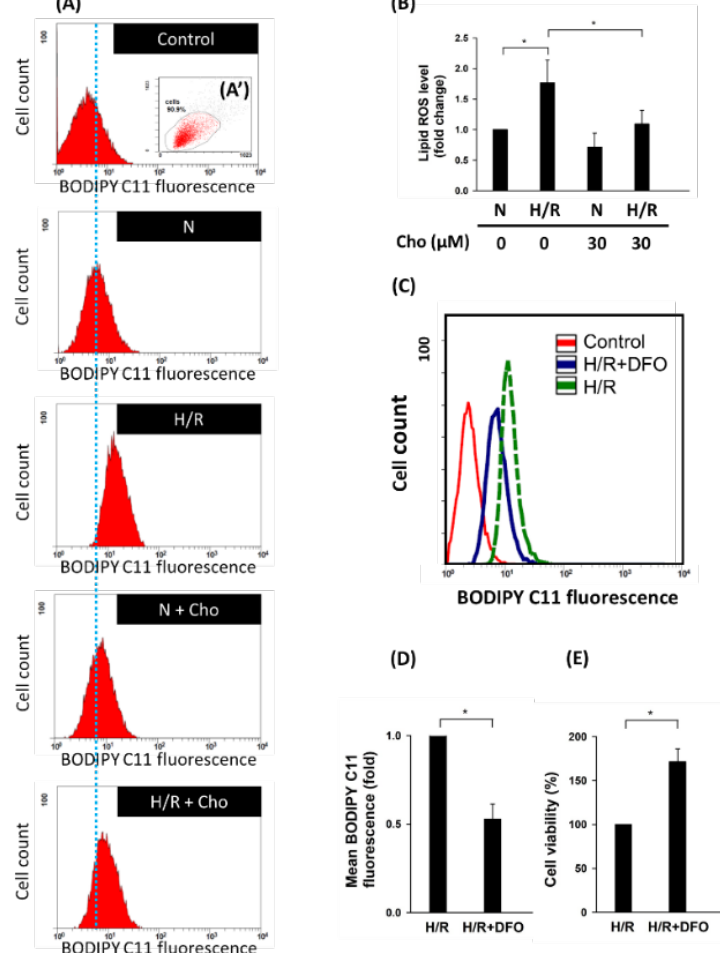
Figure 3. Chrysophanol reversed H/R-induced lipid ROS production. ( A ) Changes in cellular lipid ROS levels of control (without C11-BODIPY staining), N (cells grown in normal oxygen conditions without chrysophanol treatment), H/R (cells cultured in hypoxia/reoxygenation conditions, as described in Section 2), N + Cho (cells grown in normal oxygen conditions with 30 µ M chrysophanol treatment), and H/R + Cho (cells cultured under hypoxia/reoxygenation conditions with 30 µ M chrysophanol treatment) groups. (A) Cells were selected based on morphology. ( B ) ROS generation is expressed as mean fluorescence intensity. ( C ) Changes in cellular lipid ROS levels of control (without C11-BODIPY staining). H/R + DFO (cells cultured under hypoxia/reoxygenation conditions with 100 µ M Desferal treatment for 1 h) groups ( D ) Lipid ROS generation is expressed as mean fluorescence intensity. ( E ) Cell viability was determined using WST-1 assays for the indicated groups of cells. Error bars represent the standard deviation from three independent replicates. n = 3. * p < 0.05.